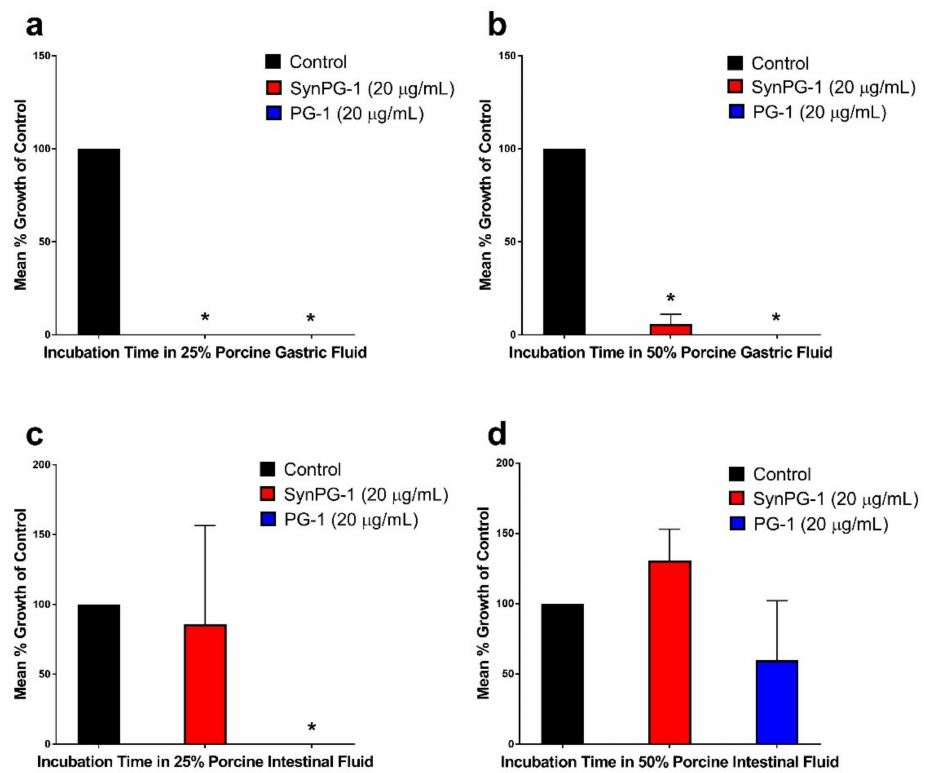
Figure 4. Stability of PG-1 and SynPG-1 in porcine digestive fluid, represented by the mean % bacterial growth of control when tested against E. coli after peptides were incubated in ( a ) 25% or ( b ) 50% gastric fluid and after peptides were incubated in ( c ) 25% or ( d ) 50% intestinal fluid. Peptides were both tested at a concentration 10 times their MBC (20 µ g / mL). Stability was evaluated by comparing the mean growth of colonies on plates treated with peptides incubated in digestive fluids to colonies grown when treated without peptide. All experiments were conducted three independent times. The asterisks represent significant di ff erences at p < 0.05 when compared to the control by one-way ANOVA with a post hoc Tukey